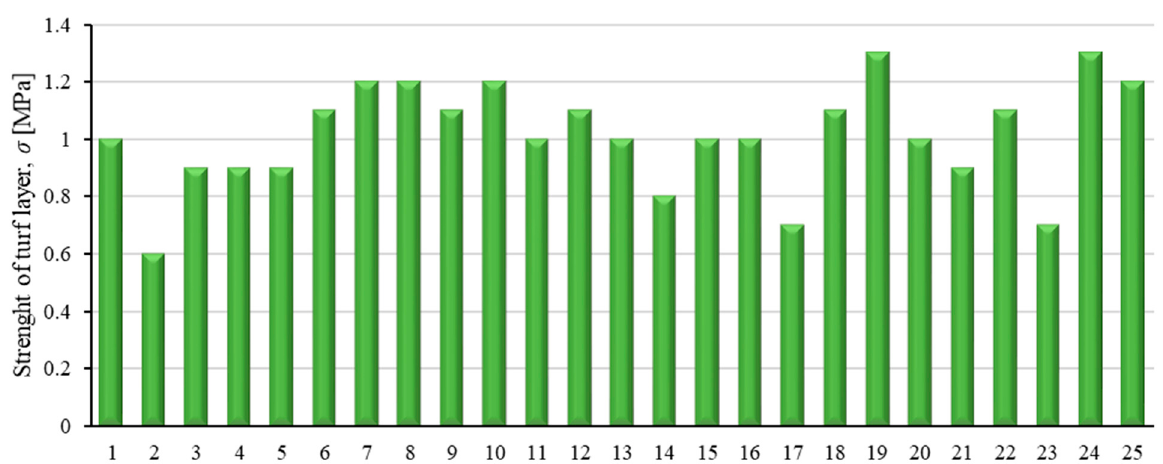
Figure 16. Results of the strength of the turf layer of the airfield pavement on the southern shoulder.